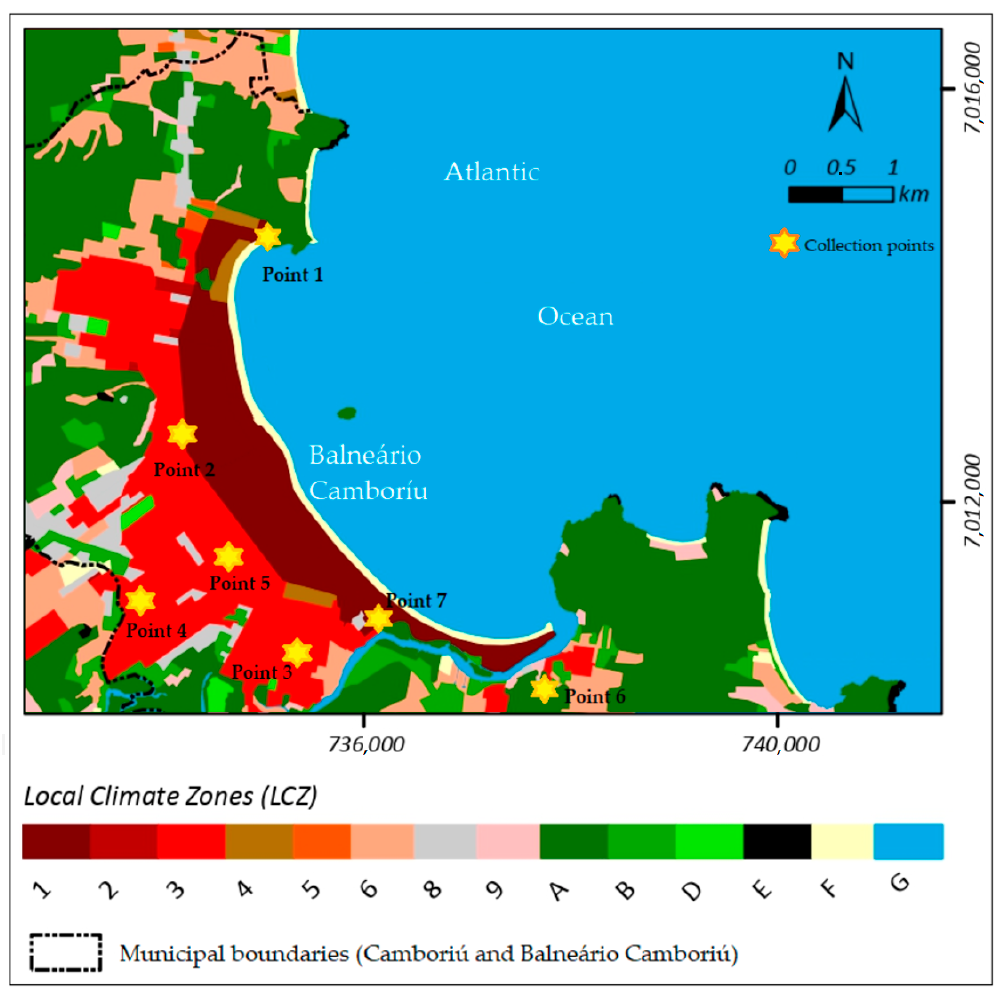
Figure 9. LCZ map of Balneário Camboriú and the locations of the points selected for the survey. Source of the cartographic base: City Hall of Balneário Camboriú/SC (2019). Elaboration: the authors (2022).